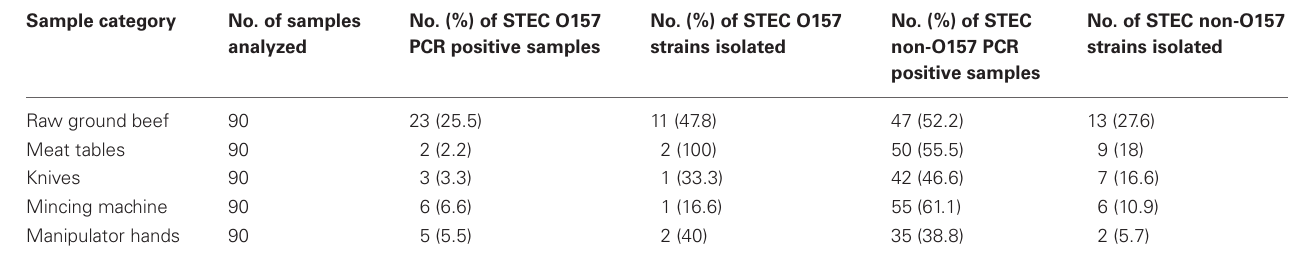
Table 1 | Number of STEC PCR-positives samples and strains isolated from different sources. Sample